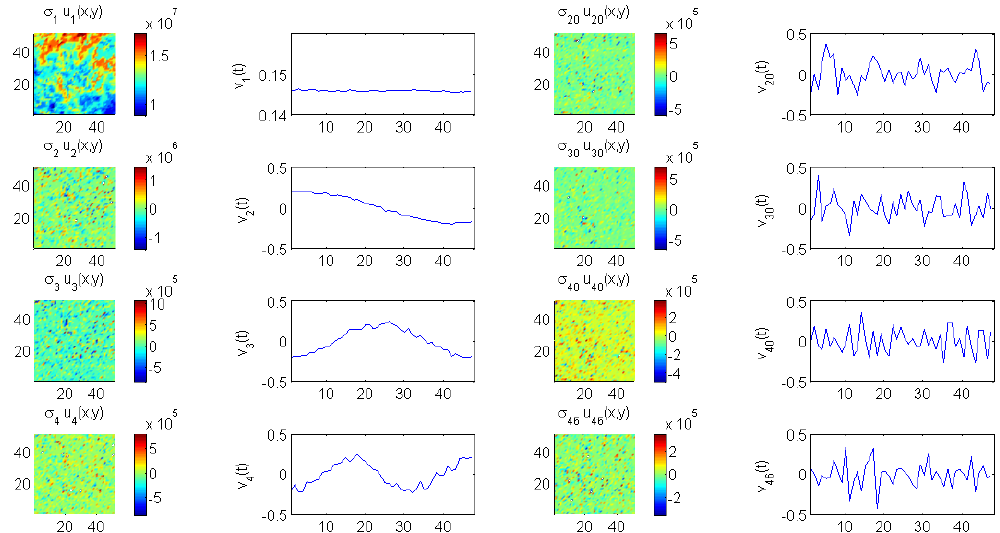
Figure 6. Topos–Chronos decomposition of the quiet-Sun region. Odd columns: spatial modes u k (r i ) ; even columns: temporal modes v k (t j ) for k = 1, 2, 3, 4, 20, 30, 40, 46. One unit on the time axis equals 12s.